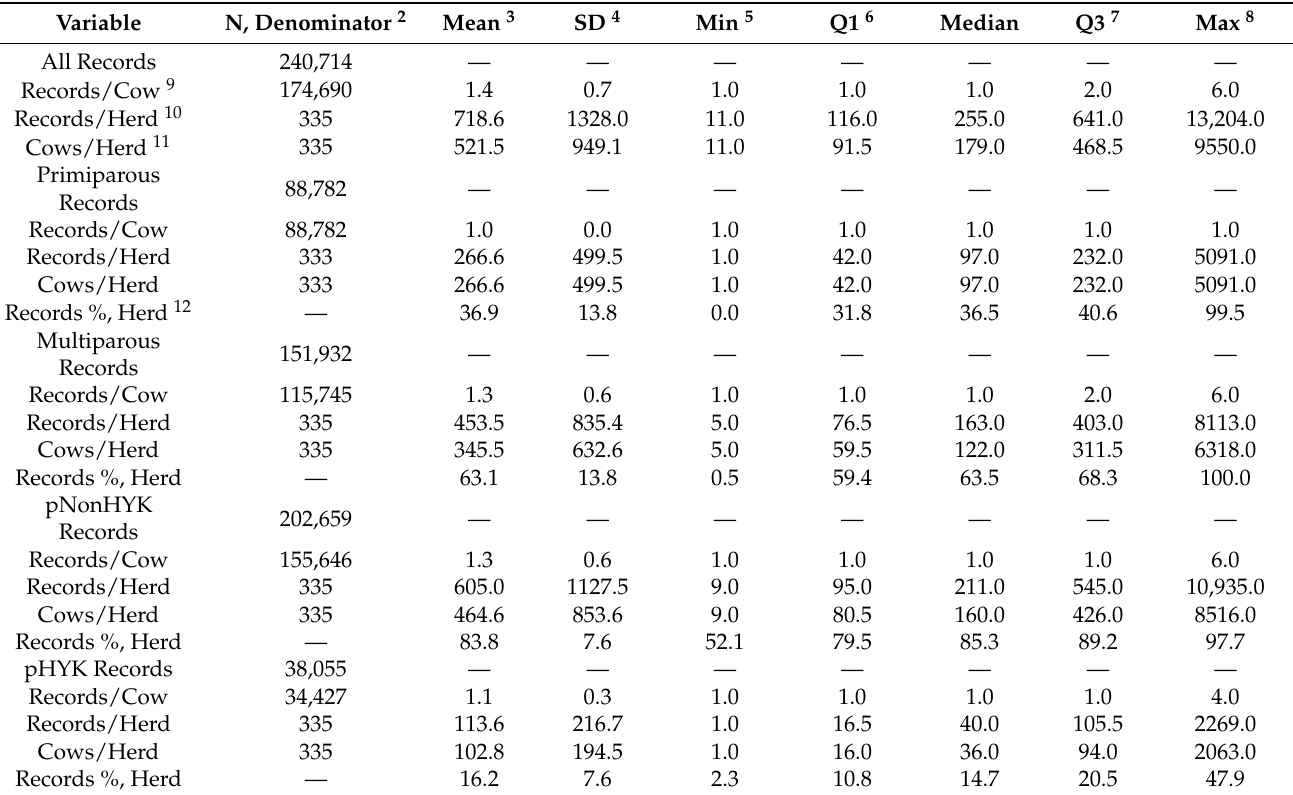
Table 1. Descriptive Statistics of Test Day Samples Collected from Cows between 5 and 20 Days in Milk and Classified into